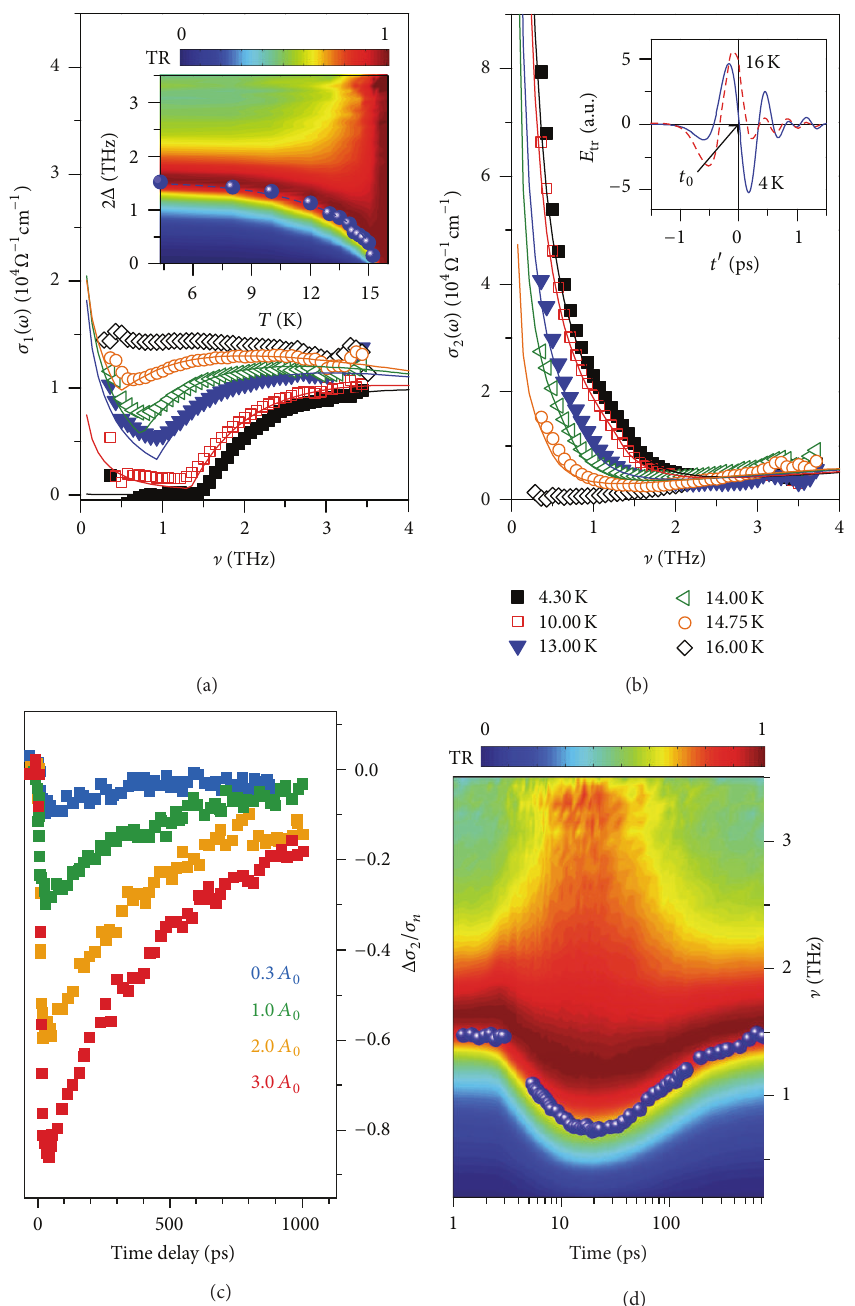
Figure 18: Temperature-dependence of the (a) real and (b) imaginary parts of the conductivity spectra obtained on a 15nm NbN film on MgO substrate ( 𝑇 𝑐 = 15.4 K). The solid lines are fits with the Mattis-Bardeen equations [27, 28]. The inset of panel (a) shows the temperature dependence of the energy gap 2Δ , extracted from fits to 𝜎(𝜔) (symbols) overlaying the normalized transmissivity ratio, TR. The BCS temperature dependence of Δ is shown by the dashed line. The inset to panel (b) displays the transmitted THz transients through the NbN film below and above 𝑇 𝑐 ; the arrow denotes the time 𝑡 󸀠 = 𝑡 0 with maximum change in the transmitted electric field (after [108]). (c) The recovery of the imaginary part of the superconducting conductivity for different intensities can be described by a single exponential dependence with 𝜏 = 580 ps [107]. (d) Time evolution of normalized transmissivity ratio (TR), recorded at 𝐴 = 22 mJ/cm 3 , together with (𝜔,𝑡 ) fit with the BCS theory [27, 28] (after Δ(𝑡) extracted from 𝜎 1 𝑑